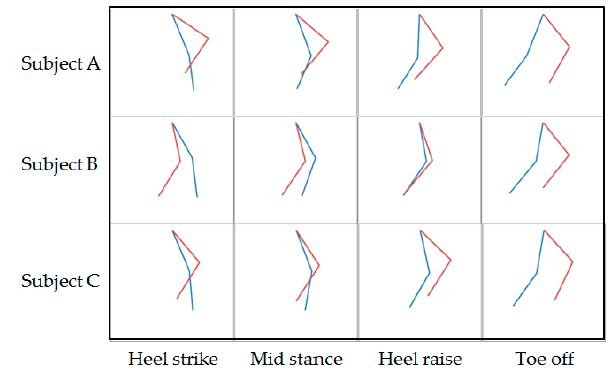
Figure 3. The EP posture (red) and actual leg posture (blue).